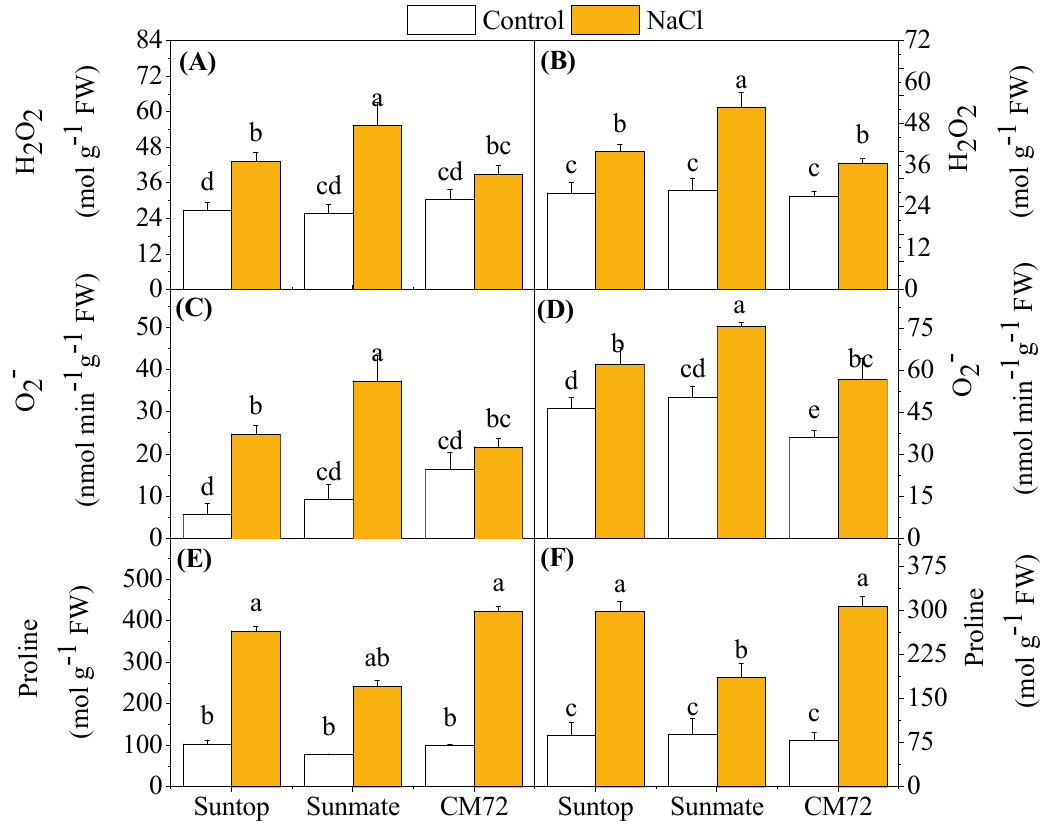
Figure 4. Accumulation of H 2 O 2 ( A , B ), O 2– ( C , D ), and proline content ( E , F ) in leaves (left panel) and roots (right penal) of two wheat cultivars—Suntop, Sunmate—and barley cultivar CM72 exposed for 7 days to 100 mM of NaCl. Data are means ± SD (n = 4). Different letters indicate a significant difference ( p ≤ 0.05) between NaCl treatment and control within the two wheat cultivars and barley cv. CM72.